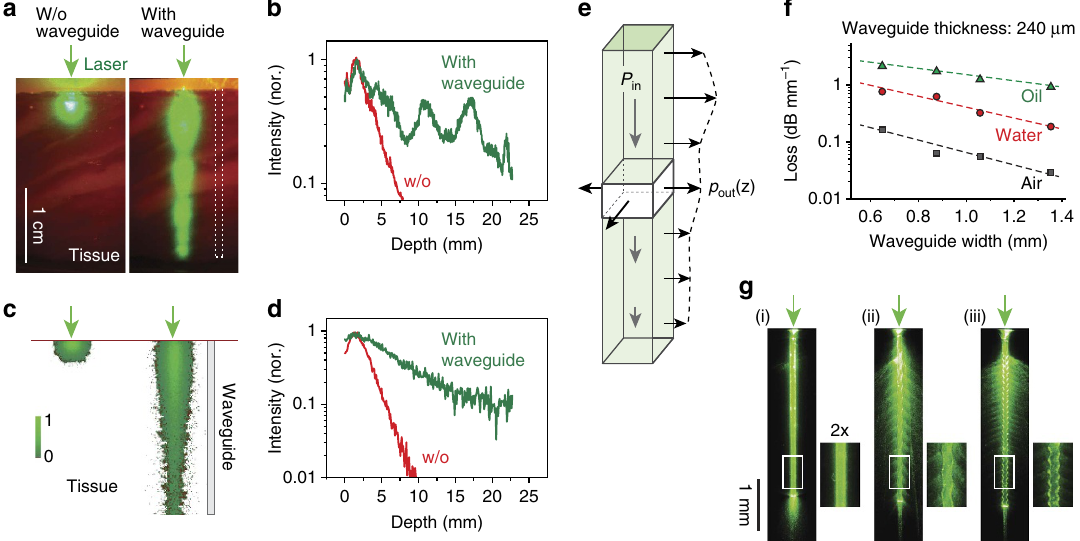
Figure 2 | Propagation of light in biopolymer-based planar waveguides. ( a ) Microscopic image of the light in bovine tissue (thickness B 2mm) taken before (left panel) and after (right panel) insertion of the waveguide. Left panel: an external light source of a green laser is directly applied to the surface of the tissue. Right panel: a green laser is coupled to a waveguide implanted into the tissue. Scale bar, 10mm. ( b ) Profile of the light decay in the tissue with (green line) and without (w/o; red line) the waveguide. ( c ) Two-dimensional ray simulations of light propagation using the same geometry as for experimental measurement in a . ( d ) Profile of the simulated light decay. ( e ) Schematic representation of the light extraction from a planar waveguide. P out ( z ) corresponds to the light extraction profile from the waveguide, and P in ( z ) corresponds to input per unit length. ( f ) Measured propagation loss of the waveguides in air, water and oil for increasing waveguide widths and at a constant height of 240 m m. ( N ¼ 1 for each medium; R 2 is 0.979, 0.938 and 0.906 in oil, water and air, respectively. ( g ) Waveguides with different surface patterns enable tuning the light extraction profile; here, in air. Light is coupled to the waveguide by focusing a laser to the top end of the waveguide. Scale bar, 1mm. nor., environments: in air ( n ¼ 1), water ( n ¼ 1.33) and oil ( n ¼ 1.5), respectively. Our measurements showed that in all cases, the optical intensity in the waveguide decreased exponentially with the propagation distance, as expected from equation (2), and the loss coefficients decreased linearly with the waveguide width (Fig. 2f). For a width of 650 m m, the loss coefficient was 0.16 dB mm (cid:3) 1 or s ¼ 0.37 mm (cid:3) 1 in air, but it increases to 0.76 dB mm (cid:3) 1 in water and 2 dB mm (cid:3) 1 in oil (Fig. 2f). Most soft tissues 31 have a refractive index of 1.33–1.51. Therefore, the optical loss in vivo would fall somewhere between that of water and oil. A loss of 1 dB mm (cid:3) 1 may be adequate for an application where the majority (90%) of input optical energy is to be delivered through a tissue section over a depth of 10 mm.